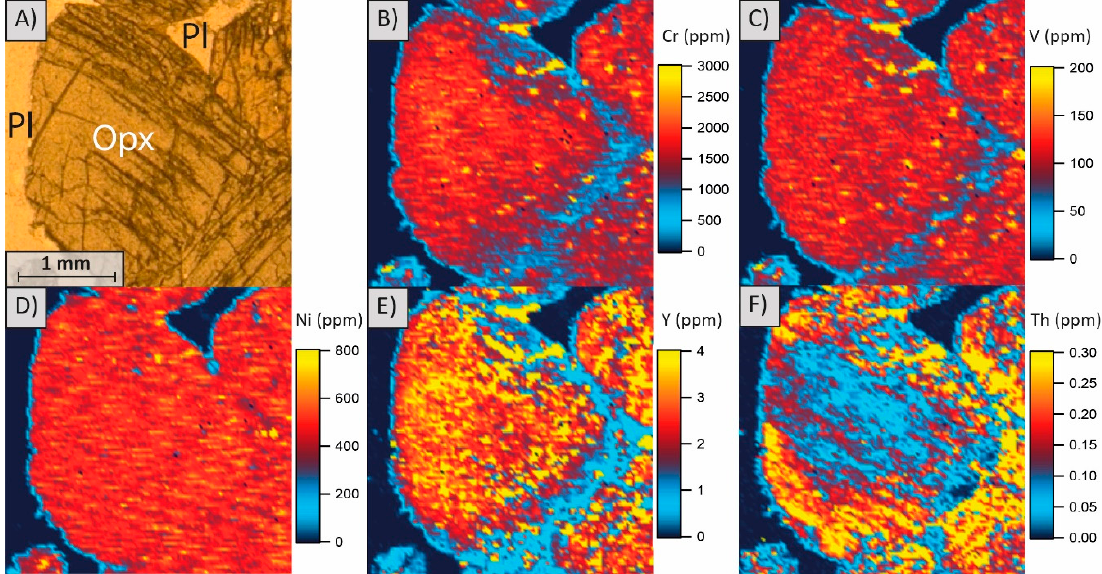
Figure 13. ( A ) Plane polarised photomicrograph of sample 308.90, Upper Distal; Pl (plagioclase), Opx (orthopyroxene); ( B ) Semi-quantitative Cr distribution map; ( C ) Semi-quantitative V distribution map; ( D ) Semi-quantitative Ni distribution map; ( E ) Semi-quantitative Y distribution map; ( F ) Semi-quantitative Th distribution map; With the exception of Ni, zonation patterns are present in all trace element distribution maps.